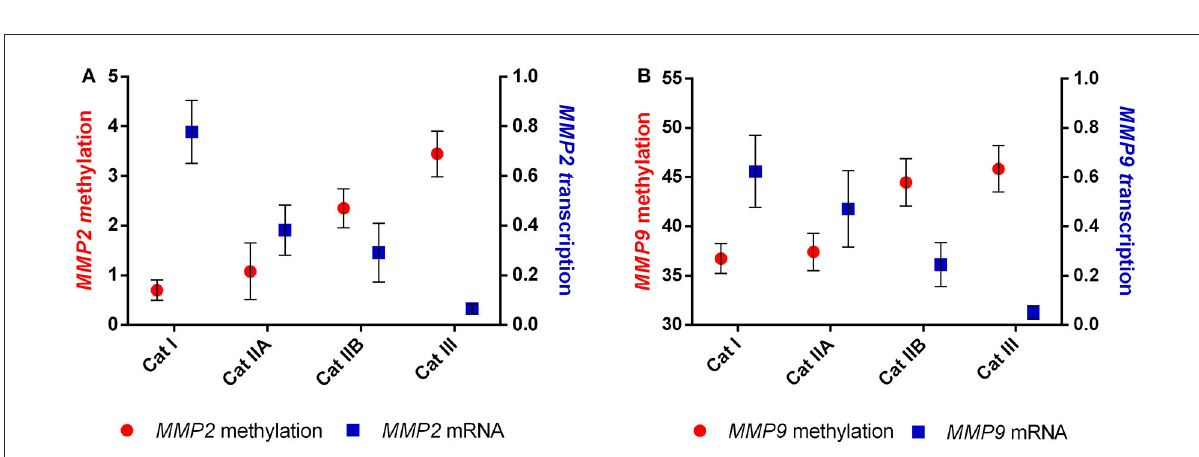
expression. The higher methylation levels observed in MMP2 and MMP9 were strongly correlated with the decreased transcription levels of both genes ( r = − 0.967, P < 0.05 and r = − 0.956, P < 0.05, respectively) upon endometrial fibrosis progression (Figure 5).